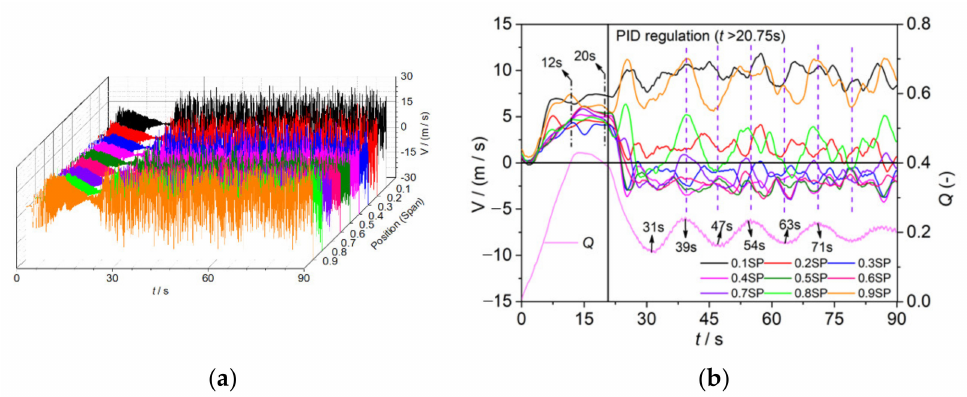
Figure 8. Radial velocity features at the runner inlet during start-up in Case1. ( a ) Original data; ( b ) The low-pass filtered